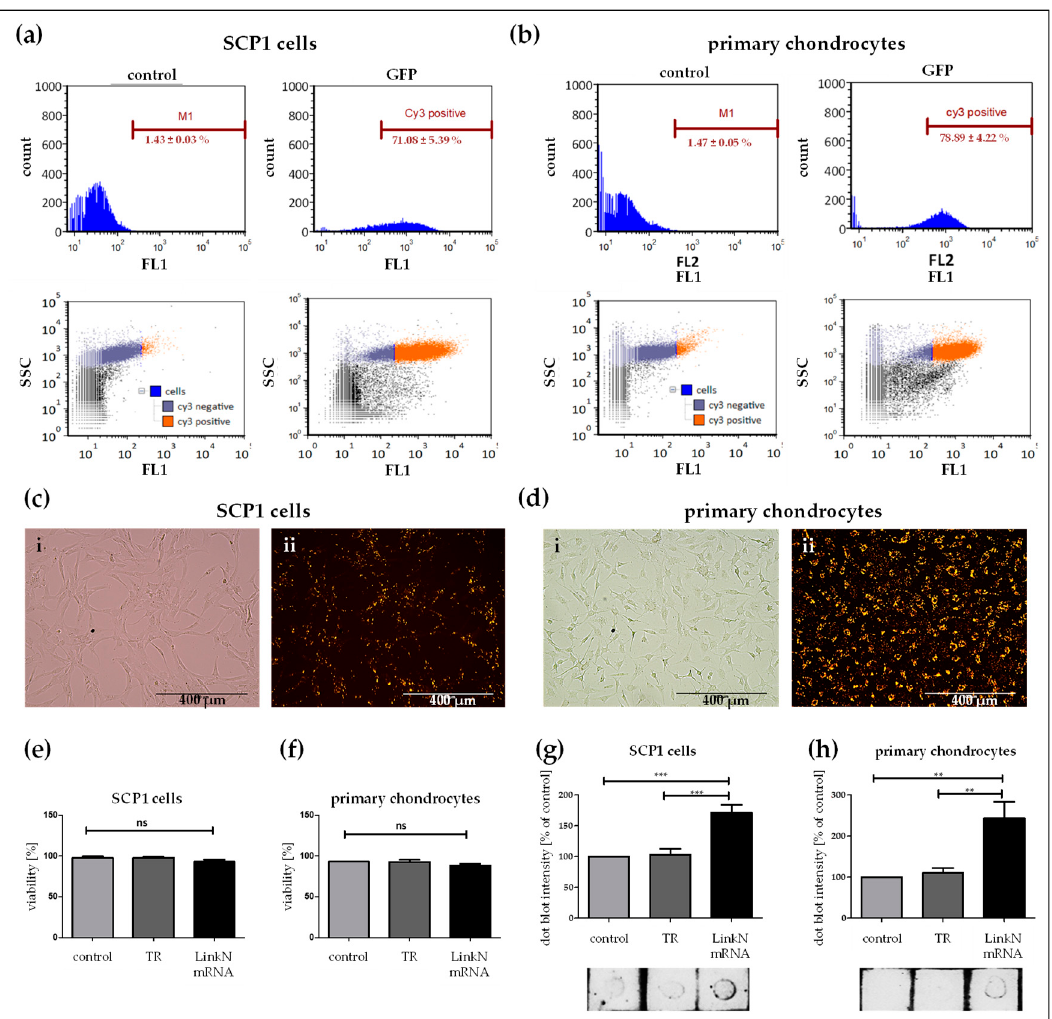
Figure 3. Analysis of Link N mRNA transfection efficiency in SCP1 cells and primary chondrocytes, and the influence of Link N mRNA transfection on cell viability. ( a , c , e , g ) SCP1 cells and ( b , d , f , h ) human primary chondrocytes were analyzed 24 h post-transfection with 1 µ g Cy3 labeled Link N mRNA using flow cytometry. Representative fluorescence microscopic images of Link N mRNA transfected cells. (i) Phase contrast bright field image, (ii) Cy3 channel image of Cy3 labeled Link N mRNA. Scale bar = 400 µ m. In vitro, cells transfected with 1 µ g of unlabeled Link N mRNA did not exhibit any adverse viability effects. Using NucleoCounter (NC-200), cell viability was assessed 24 h post-transfection. Acridine Orange and DAPI double staining identified the percentage of viable cells. Dot blot quantification of the link N peptide in the supernatant fraction of cells treated with Lipofectamine 2000, eGFP mRNA, and Link N mRNA in the cells. Untransfected cells, and cells transfected only with the transfection reagent (TR) Lipofectamine 2000, were used as controls. Data are represented as mean + SEM (N ≥ 3) and were compared using one-way ANOVA with Bonferroni’s multiple comparison test. *** p < 0.001, ** p < 0.01, ns: not